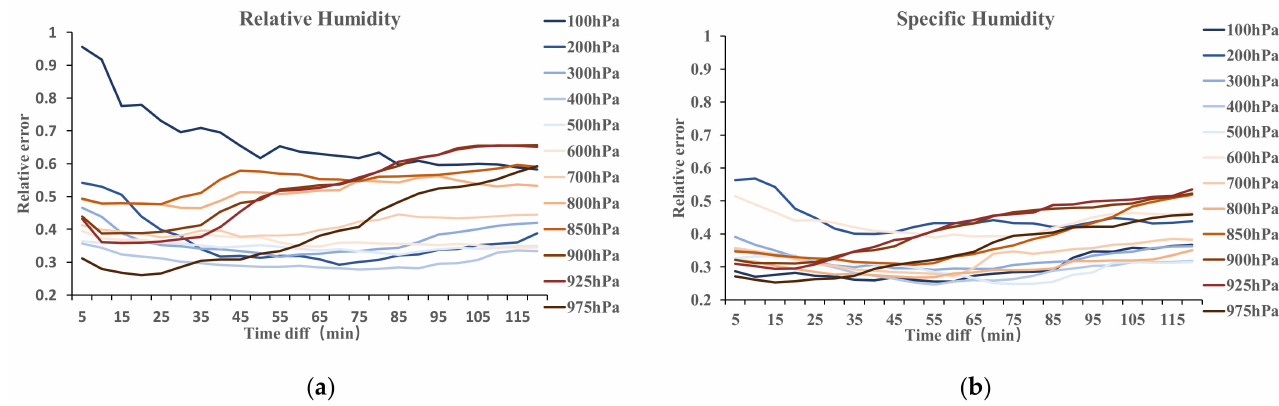
Figure 12. Wind speed RE at different heights and time intervals by using relative humidity ( a ) and specific humidity ( b ) is a